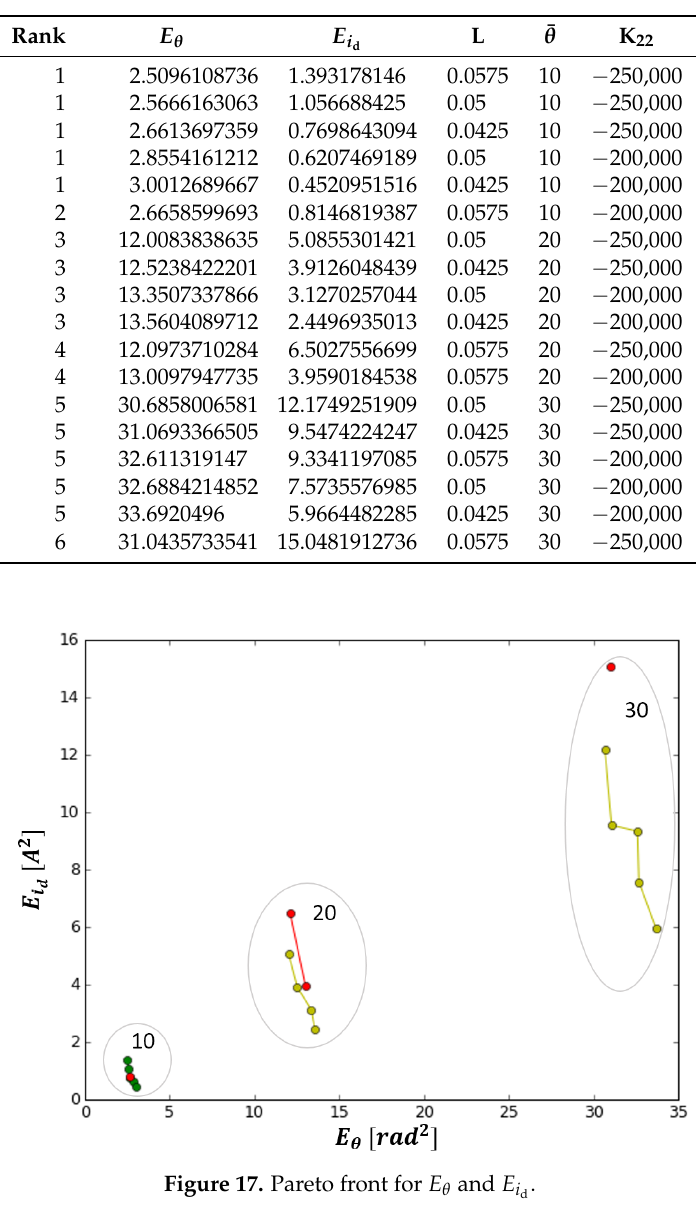
Table 6. Pareto ranking for E θ and E i